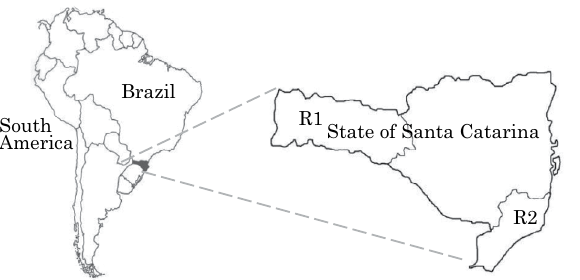
figure 1. regions of Santa Catarina, Brazil, with large concentration of pig farms. region 1 (r1) is also known as the Western region and region 2 (r2) as the Southern